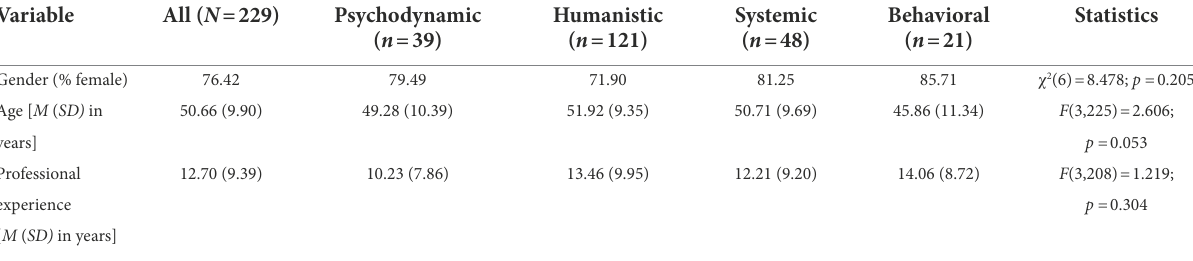
TABLE 1 Sample characteristics and comparison between the four therapeutic orientations in gender, age, and professional years.